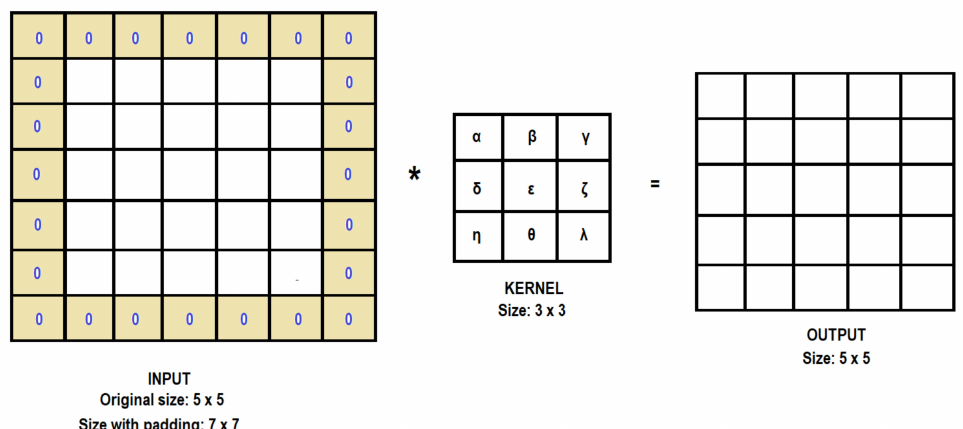
Figure 10. Padding same. The input image is filled with zeros along its border so that the output size is the same as the original input size. The symbol (*) means the convolution operator.